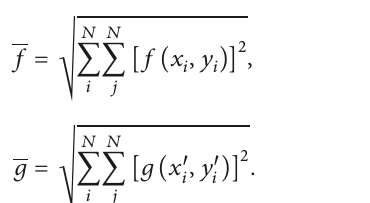
Figure 3: Specimen preparation for